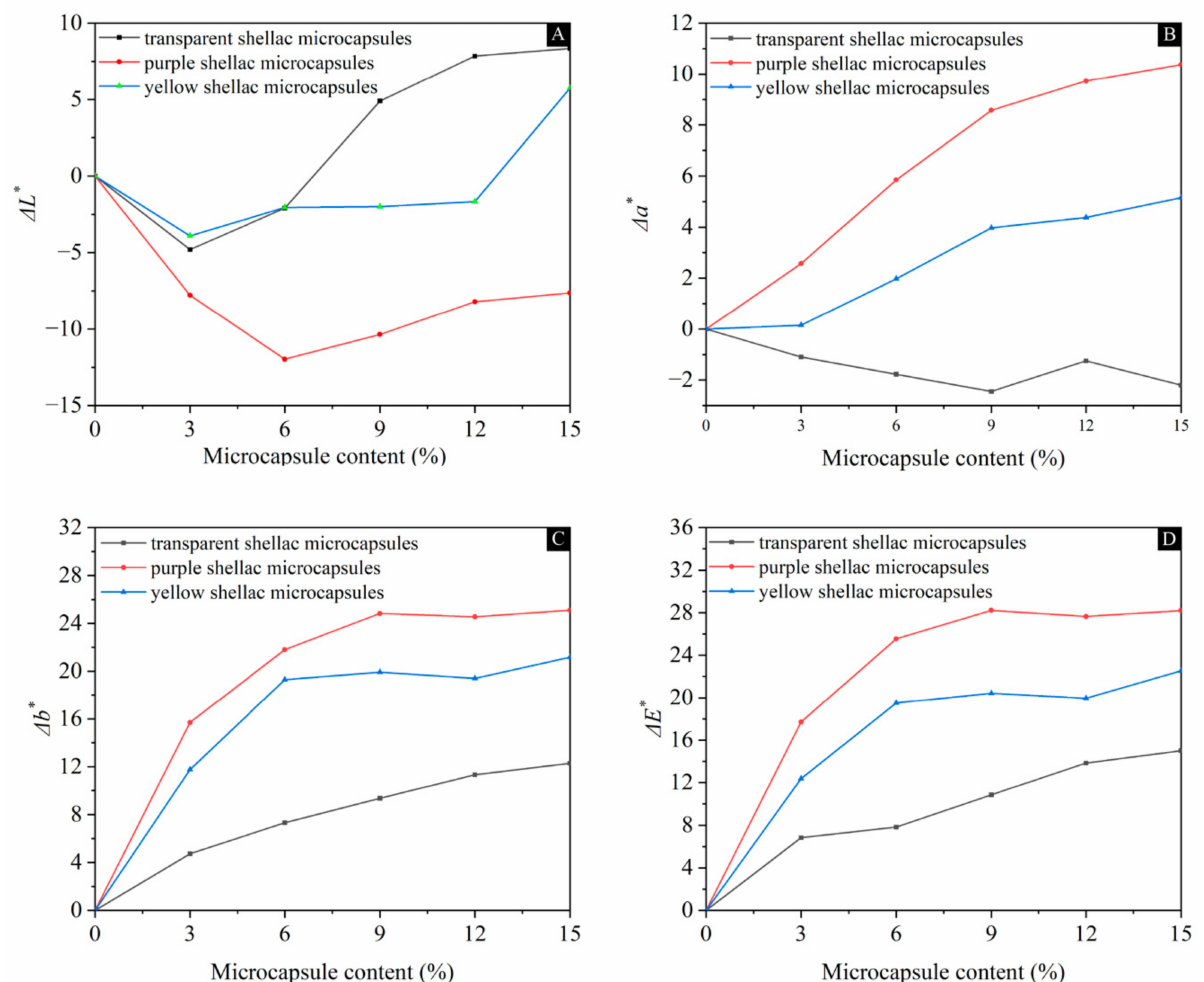
Figure 6. Relationship between loading amount of shellac microcapsules with different core materials and coating color parameters: ( A ) changes in ∆ L *, ( B ) changes in ∆ a *, ( C ) changes in ∆ b *, ( D ) changes in ∆ E